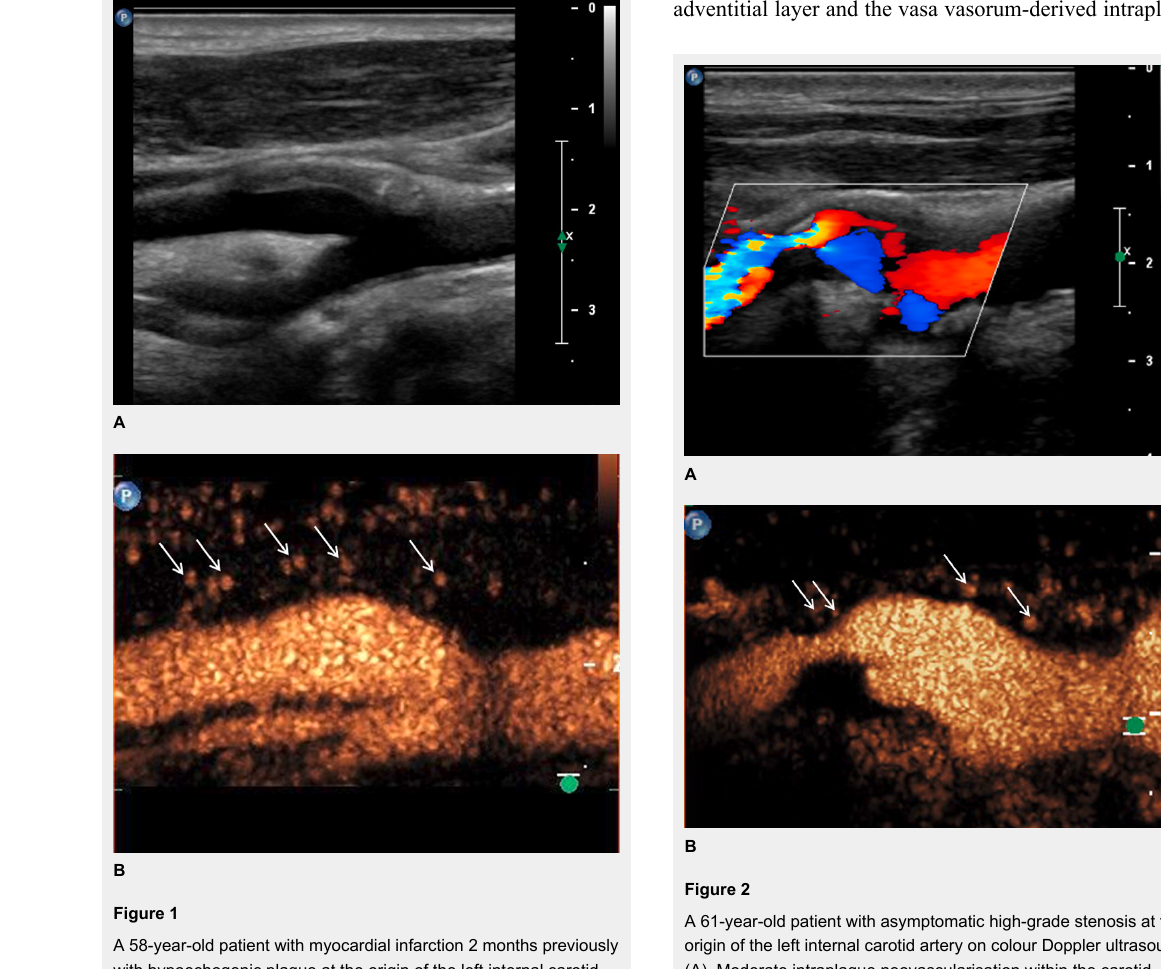
A 58-year-old patient with myocardial infarction 2 months previously with hypoechogenic plaque at the origin of the left internal carotid artery on B-mode ultrasound (A). Extensive intraplaque neovascularisation (arrows) on CEUS imaging (B).